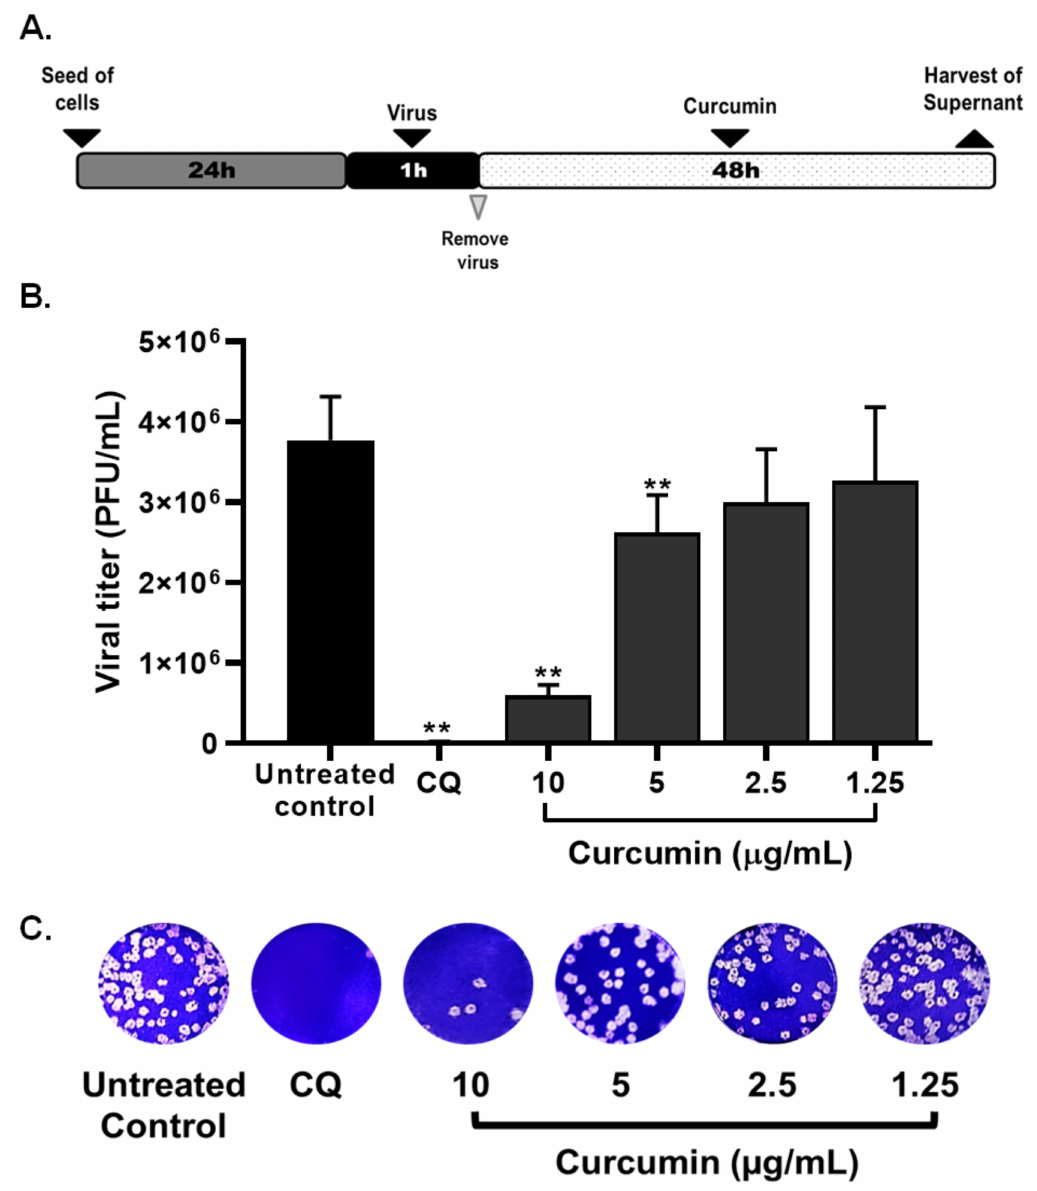
Figure 5. Curcumin inhibited the SARS-CoV-2 by post-infection treatment strategy. ( A ) Representative scheme of post- infection treatment. ( B ) The figure represents the reduction of D614G strain titer (PFU/mL) on Vero E6 supernatants after post-infection treatment with curcumin (from 1.25 to 10 µ g/mL). Chloroquine (CQ) was included as a positive control of viral inhibition. Data were presented as median ± IQR (n = 4). Mann–Whitney test ** p ≤ 0.01. Inhibition percentages of 84.4%, 31.7%, 21.9%, and 14.8% were obtained at 10, 5, 2.5, and 1.25 µ g/mL of curcumin, respectively. ( C ) Representative plaques on Vero E6 cells of post-infection treatment of curcumin against D614G